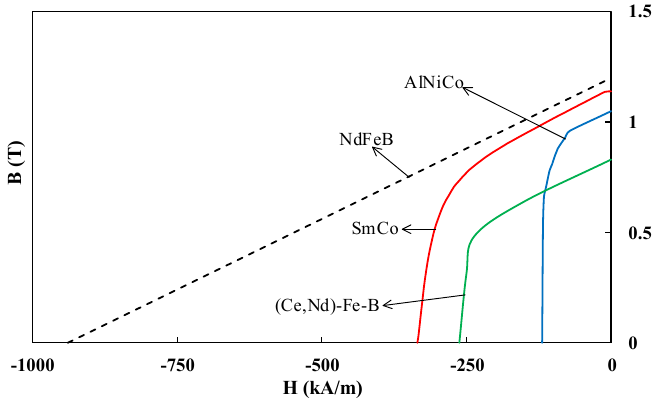
Figure 21. Typical de ‐ magnetization curves of LCF PMs.